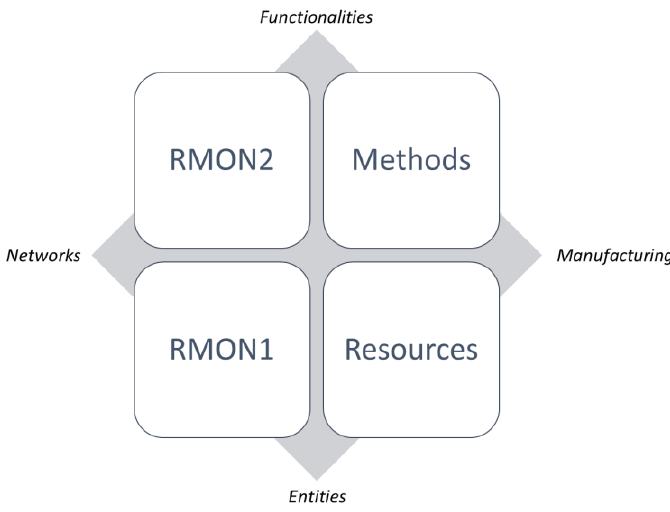
Figure 3. Analogy between SNMP taxonomy and current approach.